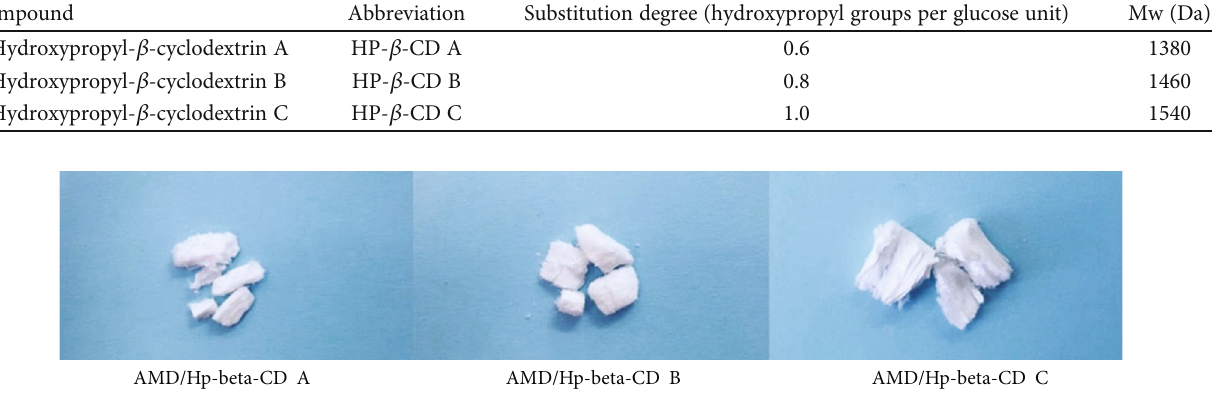
Figure 1: The aspects of the three amiodarone/2-hydroxypropyl- β -cyclodextrin complexes after